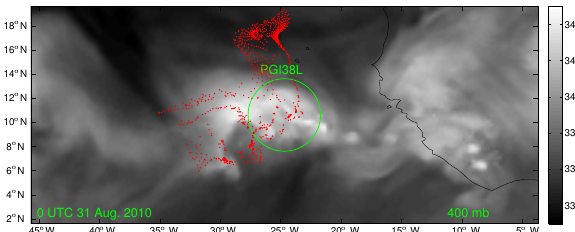
Figure 7. Particle trajectory locations at 400hPa 18:00UTC 31 Au- gust are overlaid on θ e (K) valid at 00:00UTC 31 August 2010. These trajectories are all within a radius of 3 ◦ of the pouch center (green circle) by 18:00UTC 2 September.